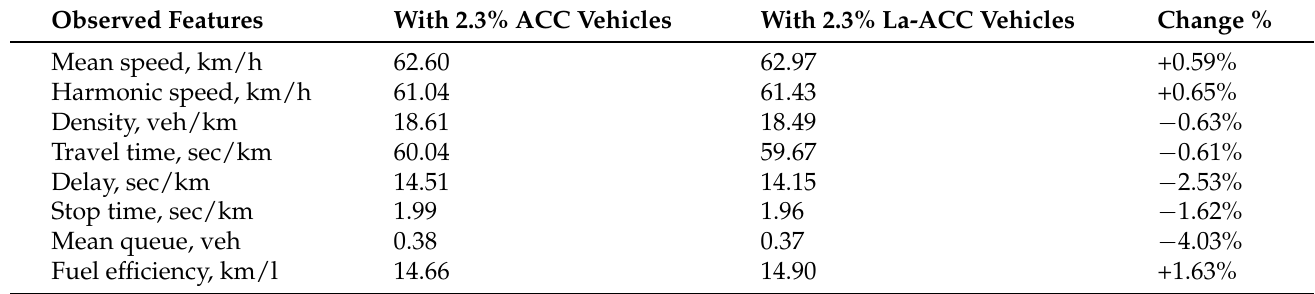
Table 1. The overall performances of traffic: comparison of La-ACC over ACC in mixed